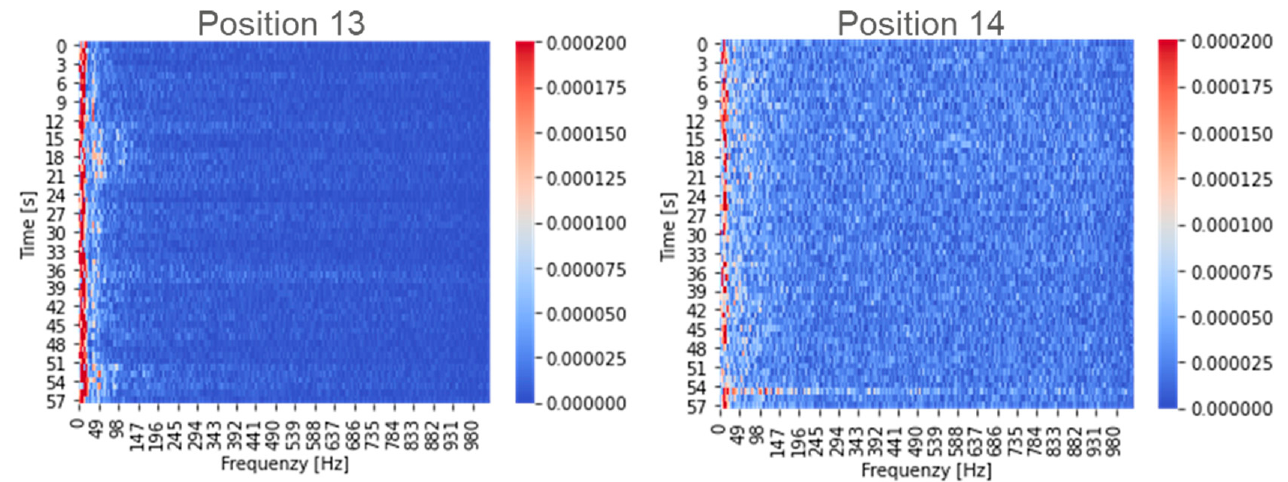
Figure 6. Fast Fourier Transformed vibrometer data over the 60 s measurement interval at position 13 and 14 before and behind the descaler.